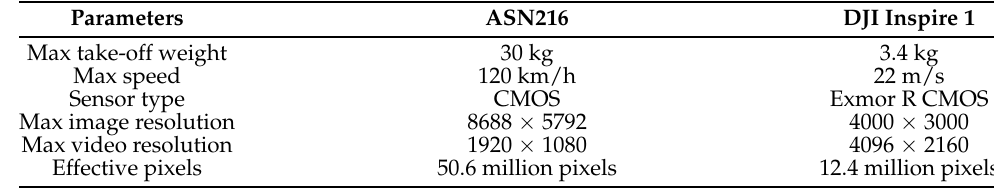
Table 1. Details of fixed-wing UAV (unmanned aerial vehicle) ASN216 and DJI Inspire 1. Parameters